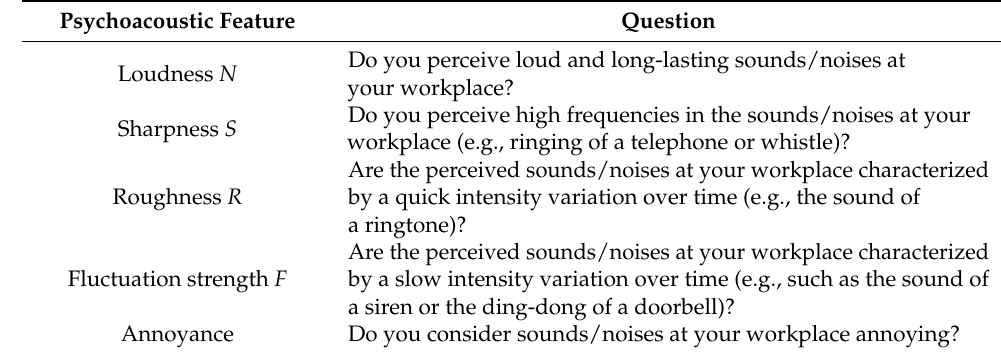
Table 3. Questions in survey 2 for each psychoacoustic feature.